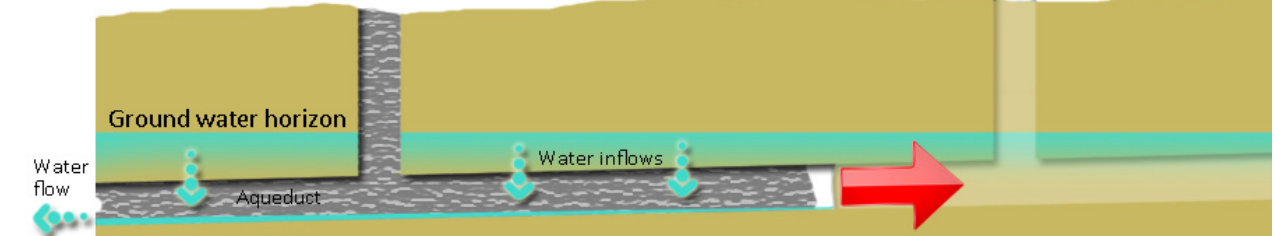
Figure 25. Linear construction, where the aqueduct is under the groundwater horizon.